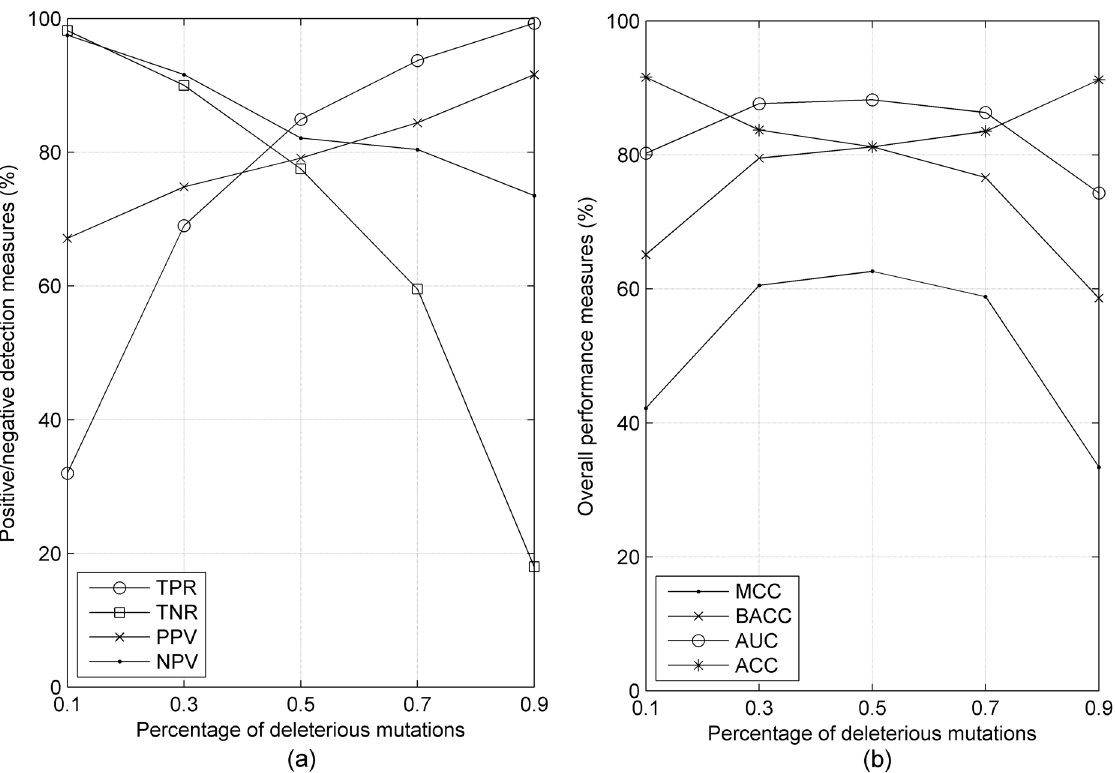
Figure 2. The cross-validation results of five SVM models trained on data sets that are 10%, 30%, 50%, 70% and 90% deleterious mutations (x-axis=0.1, 0.3, 0.5, 0.7 and 0.9 respectively). (a) Values for TPR, TNR, PPV, and NPV. (b) Values for MCC, BACC, AUC, and ACC.